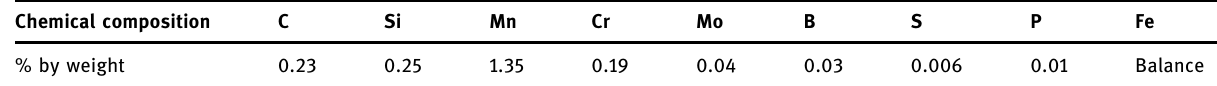
Table 1: Chemical composition of the studied BR1500HS steel Chemical composition